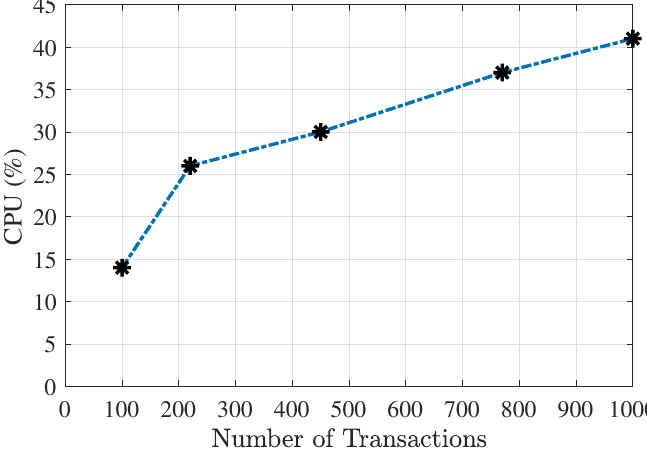
Figure 8. CPU usage for creating and broadcasting a number of